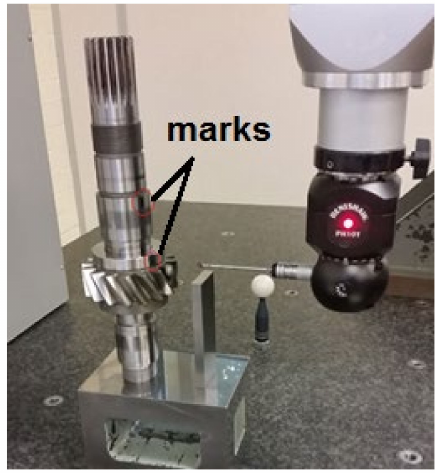
Figure 8. Measurement of gear location.4. Results and Discussion.